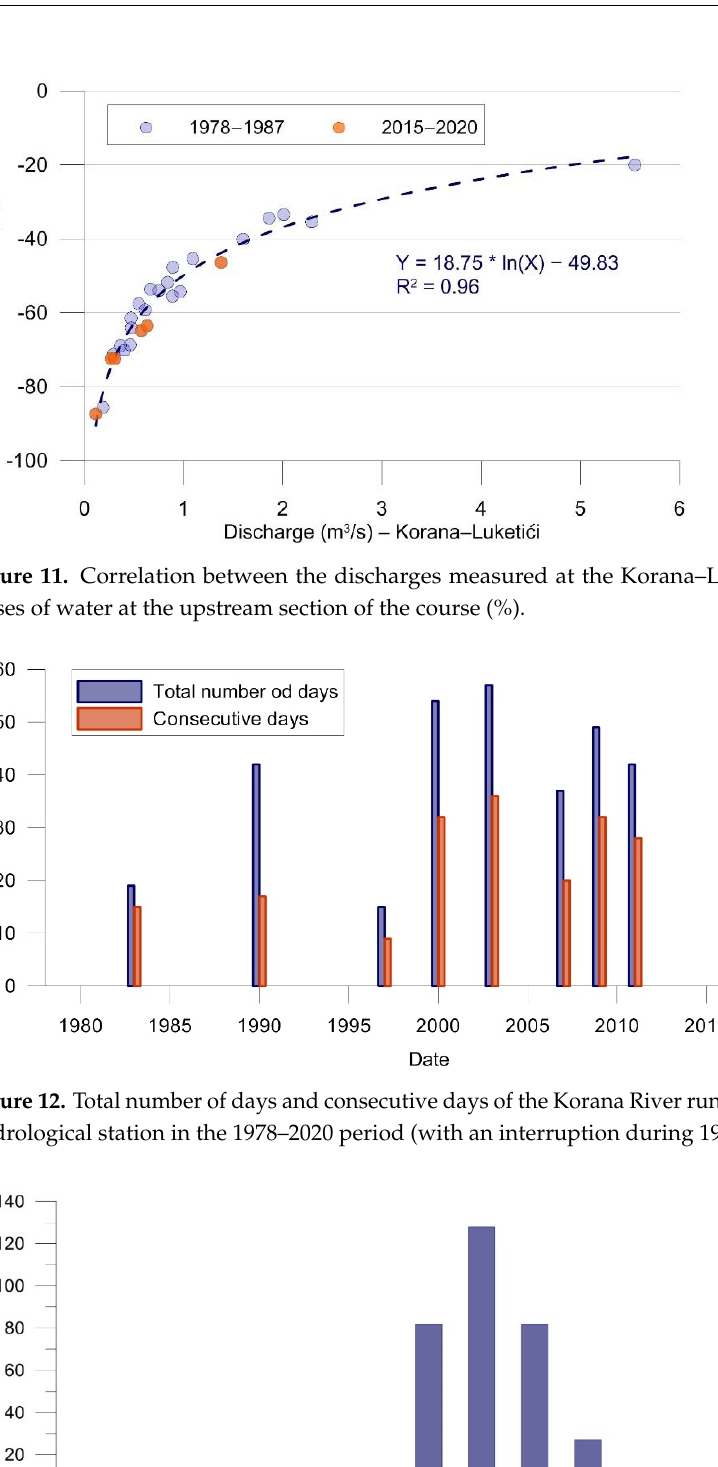
19 of 28 Figure 10. ( a ) Positions of discharge measurement profiles (1—beginning of the Korana course (1a Kozjak Lake and 1b Plitvica); 2—Lajtmanov Slap; 3—Luketi ć i; 4—Korana Most). ( b ) Mean discharges for the 1978–1987 period in comparison with the losses between discharge measurement profiles for the two periods, 1978–1987 and 2015–2020. It is obvious that during the two relevant periods the losses had not changed, i.e., that the characteristics of the sinking zones in the analyzed section of impact of the Korana course had not changed. The relation between the losses and discharges measured at the Luketi ć i profile for the 1978–1987 and 2015–2020 periods during the attainment of a series of discharge meas ‐ urements is presented in Figure 11. The figure makes it clear that the relation between the losses and discharges was very strong (coefficient of determination R 2 = 0.96), confirming that the results from the recent period matched the results from the old period very well,